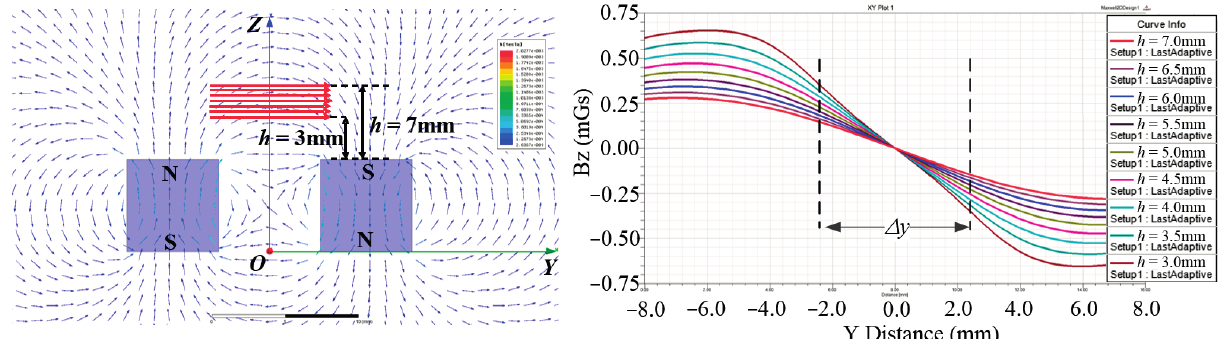
Figure 2. Installation of one Hall sensor and the permanent magnet.